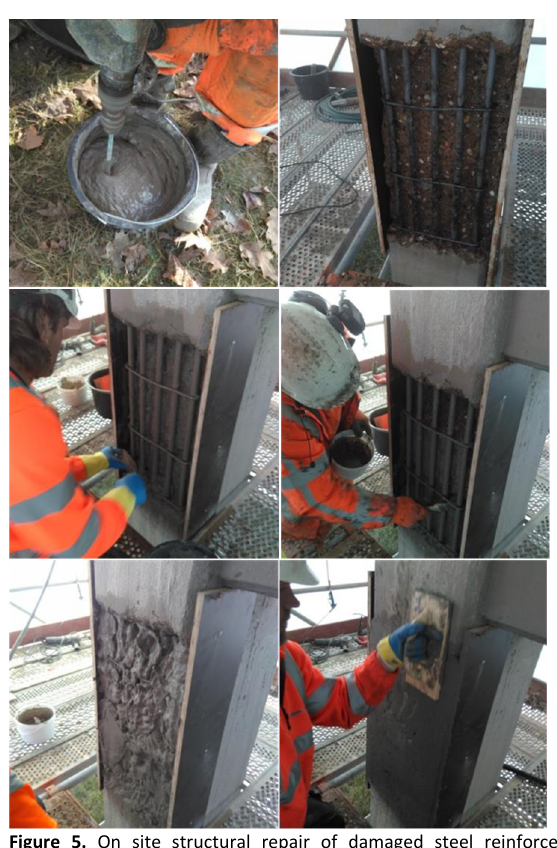
Figure 5. On site structural repair of damaged steel reinforced concrete column with bacteria ‐ based self ‐ healing repair mortar.